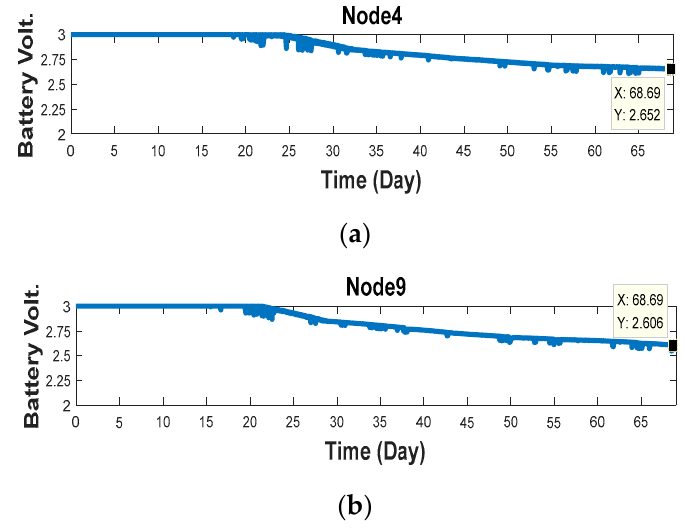
Figure 15. Nodes overall average current consumption.